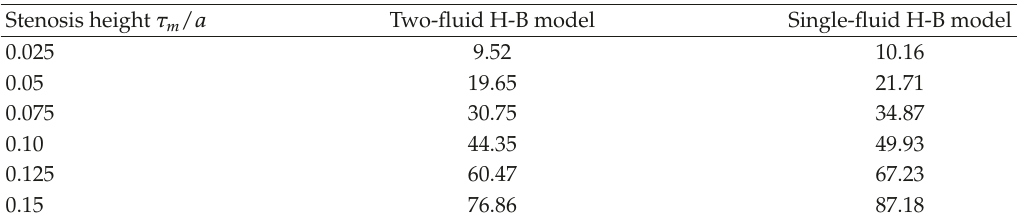
Table 1: Percentage of increase in longitudinal impedance due to the presence of stenosis for two-fluid H-B model and single-fluid H-B model with α (cid:7) 0.95, φ (cid:7) 0.0 ◦ , τ y (cid:7) 0.1, μ H (cid:7) 0.035, and μ N (cid:7) 0.3 μ H . Stenosis height τ m